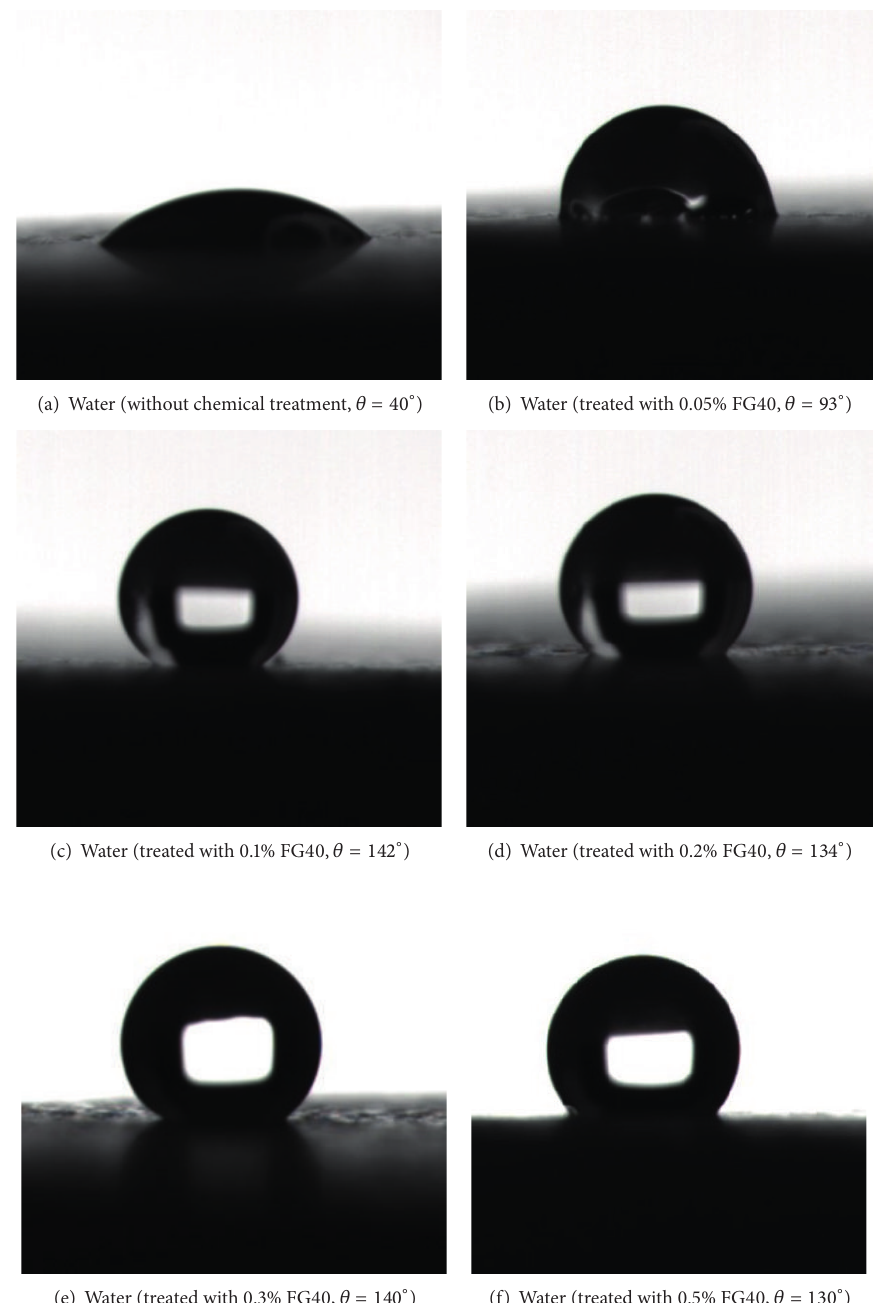
Figure 3: Water droplets on the surface of the sandstone cores before and after treatment with